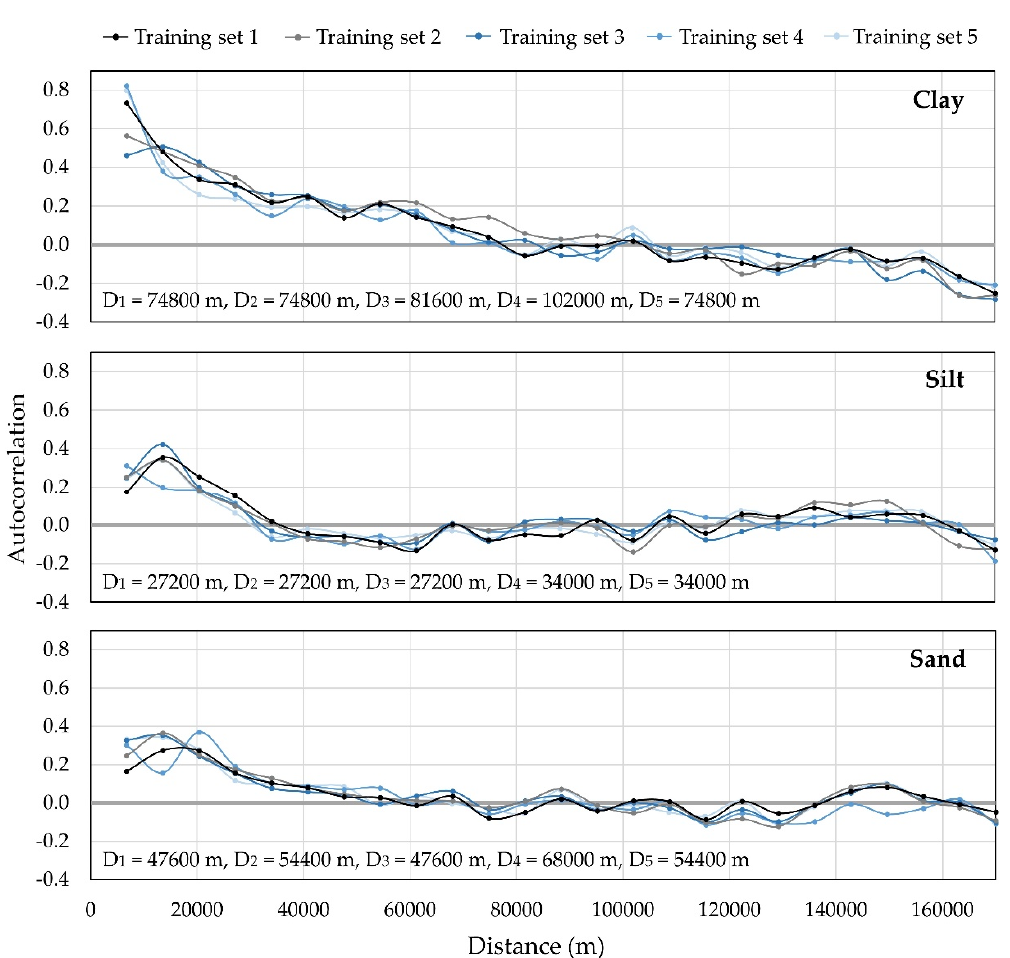
Figure A1. Autocorrelograms of five training sample sets for clay, silt and sand. D n denominates maximum distance with continuous positive autocorrelation for n training set.